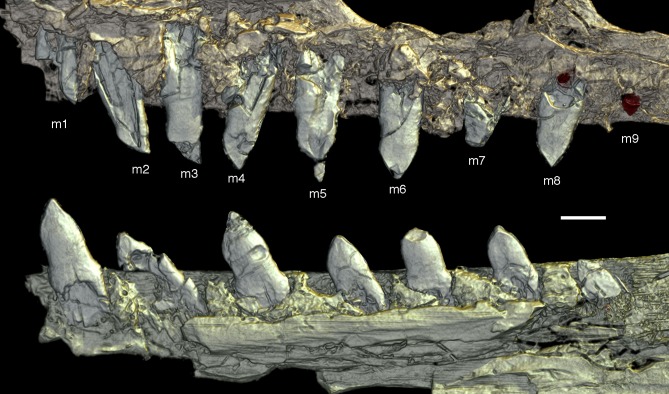
Dentition of the Daiting specimen of Archaeopteryx.Preserved maxillary (top) and dentary tooth row (bottom) in lingual view, not in their original relative positions. m, maxillary tooth positions. Tooth positions in the maxillary are based on the assumption of nine tooth positions; exact tooth positions in the dentary cannot be determined, as the element is incomplete anteriorly. Based on synchotron data; reconstruction by Paul Tafforeau, used with permission. Scale bar is 1 mm.